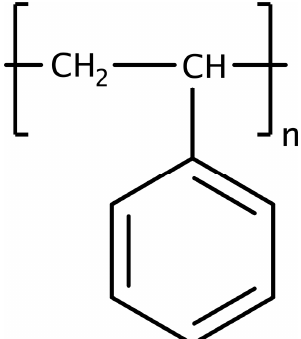
Figure 1. Molecular structure of polystyrene. Reproduced with permission from Taylor & Francis Ltd. www.tandfonline.com [4].